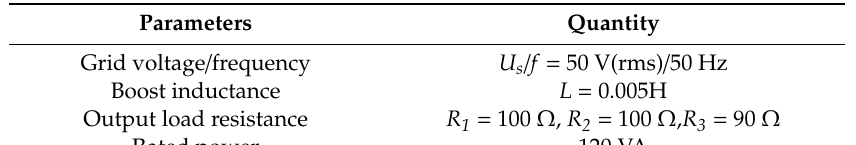
Table 2. Parameters for the system.